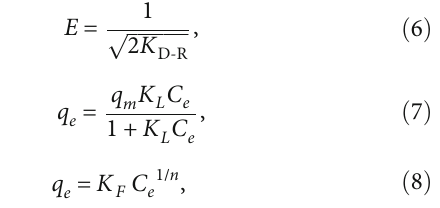
Table 4: Kinetic data for Cd(II) adsorption by Fe